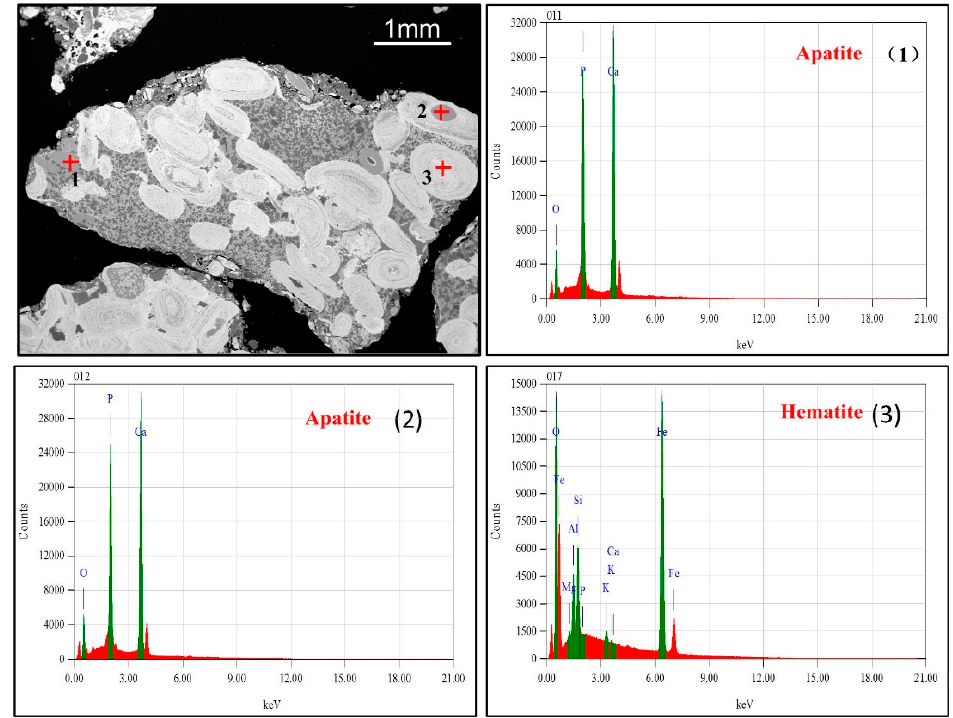
Figure 3. SEM images and EDS energy spectra of the oolitic hematite ore.